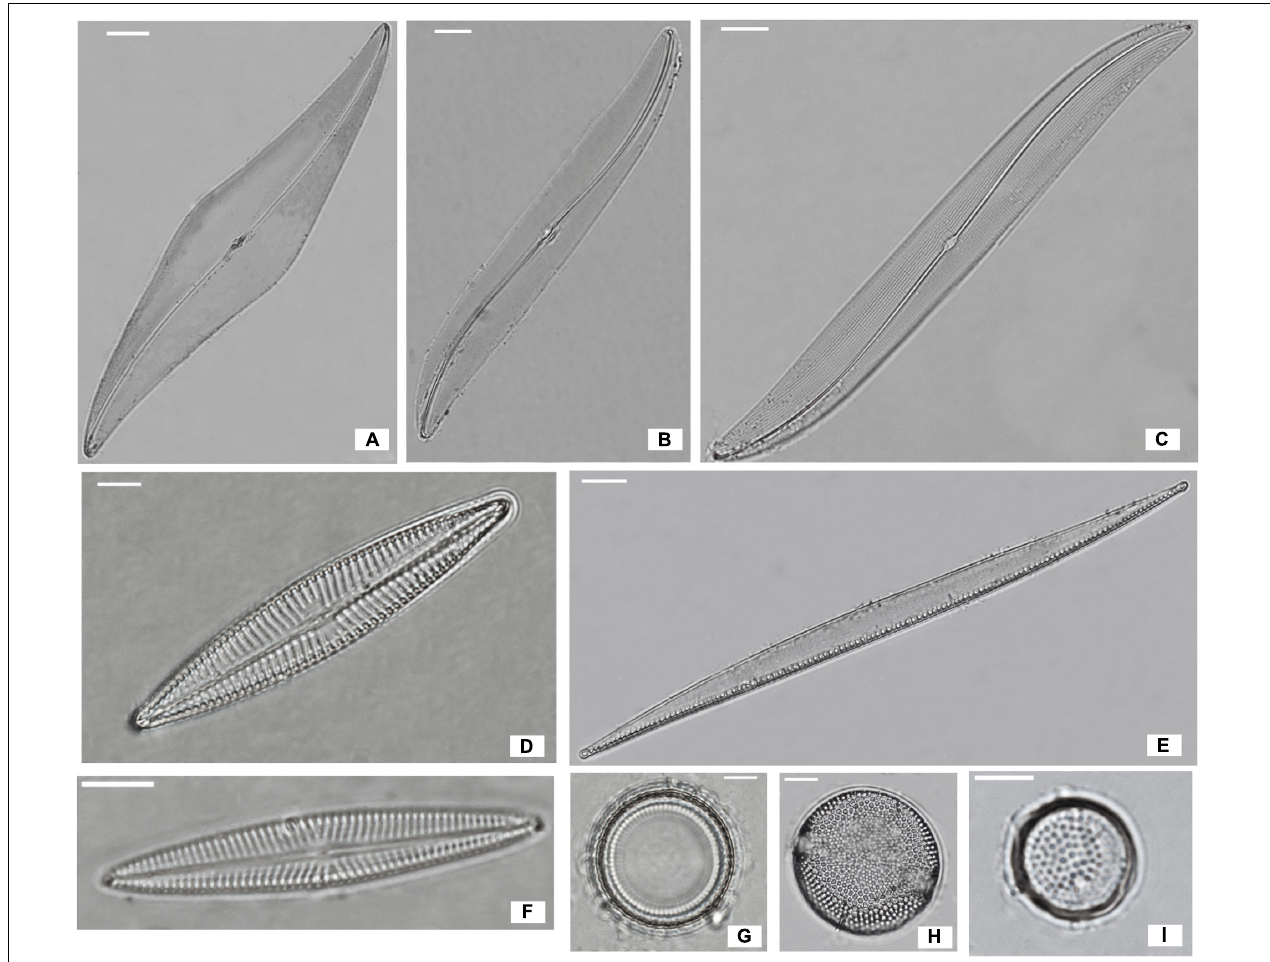
FIGURE 2 | Most abundant diatoms species of Bay de Bourgneuf site; (A) Pleurosigma angulatum (scale bar = 20 µ m); (B) Gyrosigma limosum (5 µ m); (C) Gyrosigma wansbecki (10 µ m); (D) Navicula spartinetensis (5 µ m); (E) Nitzschia cf. lorenziana (10 µ m); (F) Navicula meulemansii (5 µ m); (G) Thalassiosira cf. pseudonana (5 µ m); (H) Thalassiosira cf. angulata (5 µ m); (I) Thalassiosira cf. proschkinae (5 µ m).